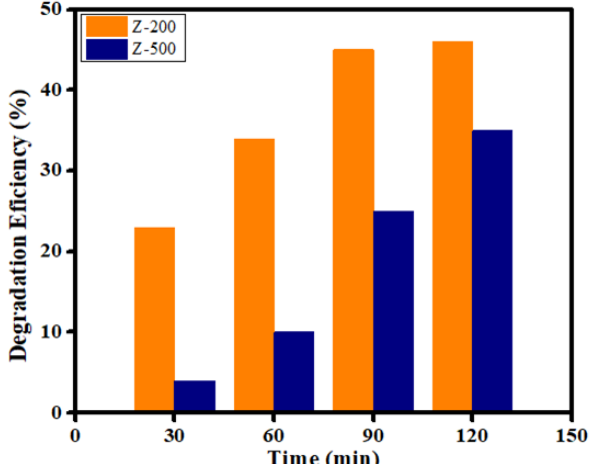
Fig 7. Percentage of degradation of MB dye after 120 minutes of